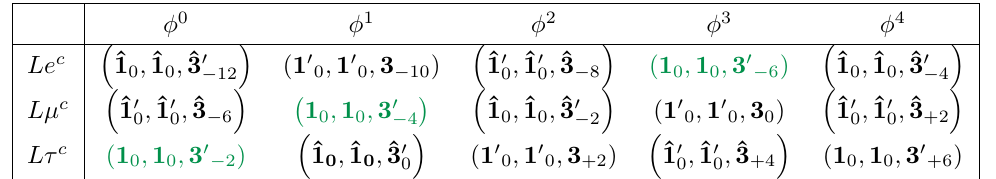
Table 7 . Irreps of the leptonic tensor products with different powers of the weighton. The invariant combinations are highlighted in